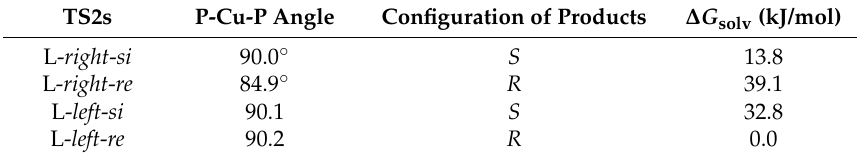
Table 4. ∆ G values of competing TS2 s in the 2,4-dimethylacetophenone/( S,S )-Ph-PBE